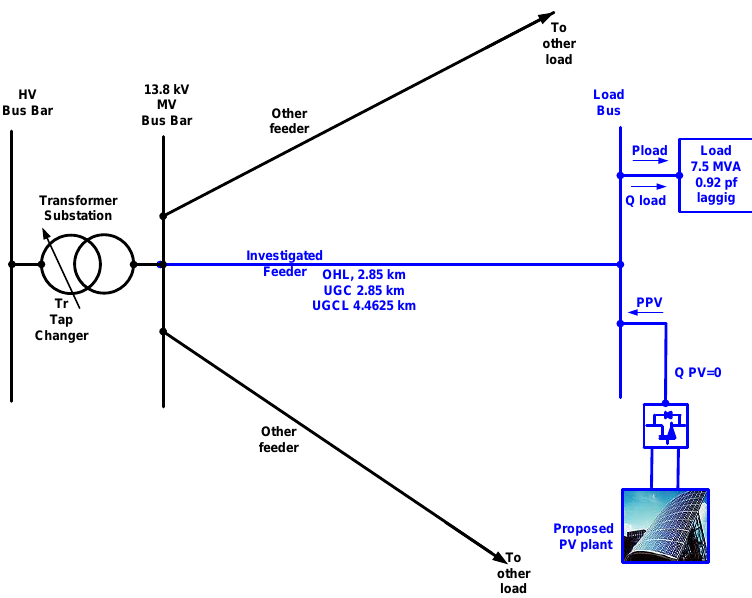
Figure 2. Single line diagram of the investigated distribution system with the proposed photovoltaic (PV) plant.